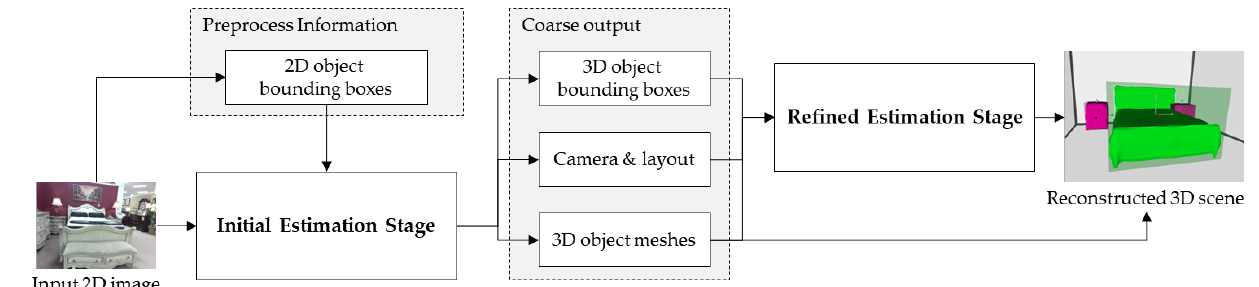
Figure 1. Pipeline of object-aware 3D scene reconstruction utilized in this study. The object-aware 3D scene reconstruction follows a coarse-to-fine manner. First, the input image is preprocessed to generate 2D bounding boxes. The initial estimation stage outputs coarse estimations, and then the refined estimation stage refines these estimates by predicting residual errors.